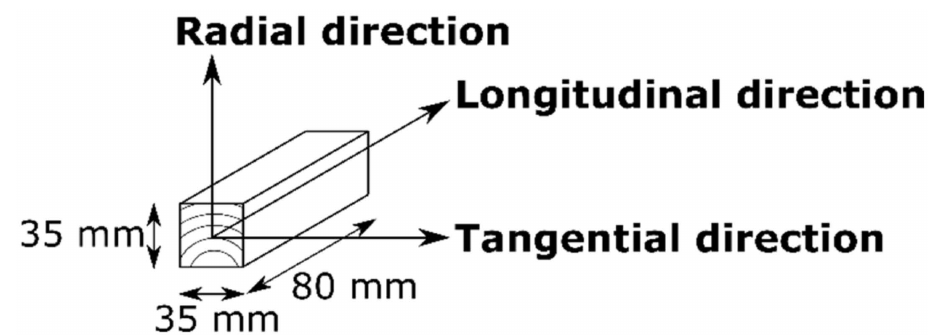
Figure 5. Wood anatomical directions of each